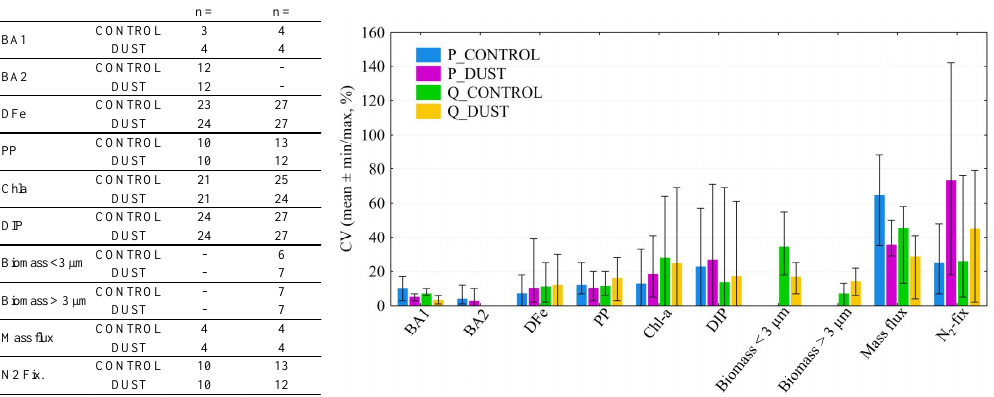
Fig. 13. Mean coefficient variation along with minimum and maximum values obtained for the measured parameters: mean values were calculated for samples collected at the same depth and time in the three mesocosms. The variation coefficients (CV, in %) derived from these calculations (CV=STDEV × 100/ mean) were then averaged for the duration of the experiment. The number “ n ” of times, three independent measurements from each group of mesocosms were considered in the calculation is reported for each experiment in the table (“BA1”: bacteria abundance from cytometry; “BA2”: bacteria abundance as determined by microscopy after dapi stained cells; “DFe”: dissolved iron; “Biomass < 3µm” and “Biomass > 3µm”: Phytoplankton biomass in two size classes; ”PP”: primary production rates; “Chl- a ”: chlorophyll- a concentration; “DIP”: dissolved inorganic phosphorus; “Mass flux”: dry weight of material collected in sediment trap; “N 2 fix”: nitrogen fixation